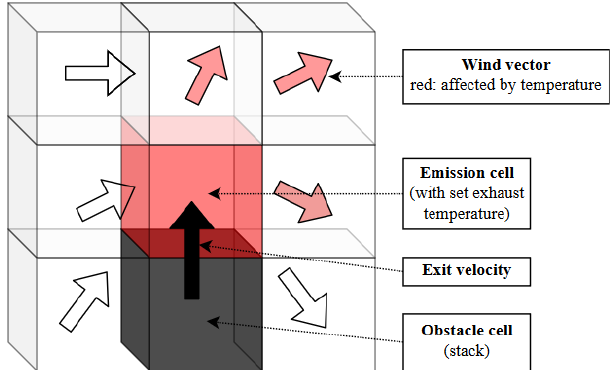
Figure 2. Visualization of the stack emission for wind direction from left to right. Passive trace gas emission occurs in the cell above the stack, which has a constant exhaust temperature and a vertically directed exhaust velocity. The arrows indicate the change of the am- bient wind field due to the obstacle and the plume